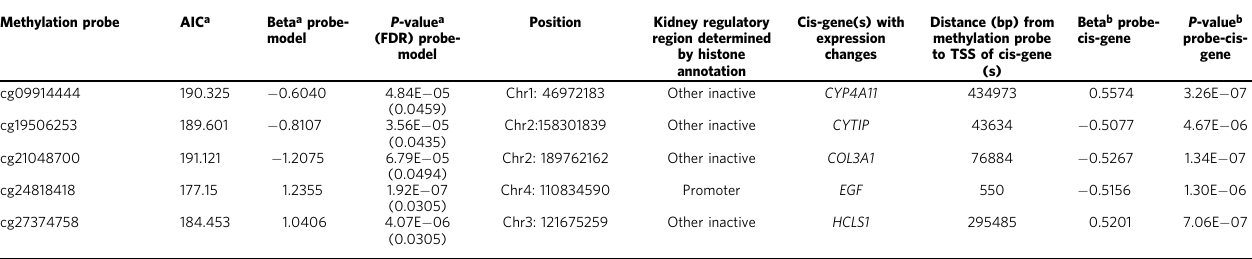
a Model is a weighted linear regression model of adjusted eGFR slope (weight = inverse variance of adjusted eGFR slope). Base model includes variables: baseline eGFR, Diabetes, and Age (base model AIC = 206). When methylation level of probe is added to base model, the following variables are also added: methylation batch, and bisul fi te conversion ef fi ciency. b Association determined by linear regression. Signi fi cance determined by random permutation method (cutoff p -value = 8e − non-diabetic kidney disease 22,31 – 35,49 . Most prior studies used modest sample sizes and most of these results failed to pass genome wide signi fi cance levels. Changes observed in renal tubule